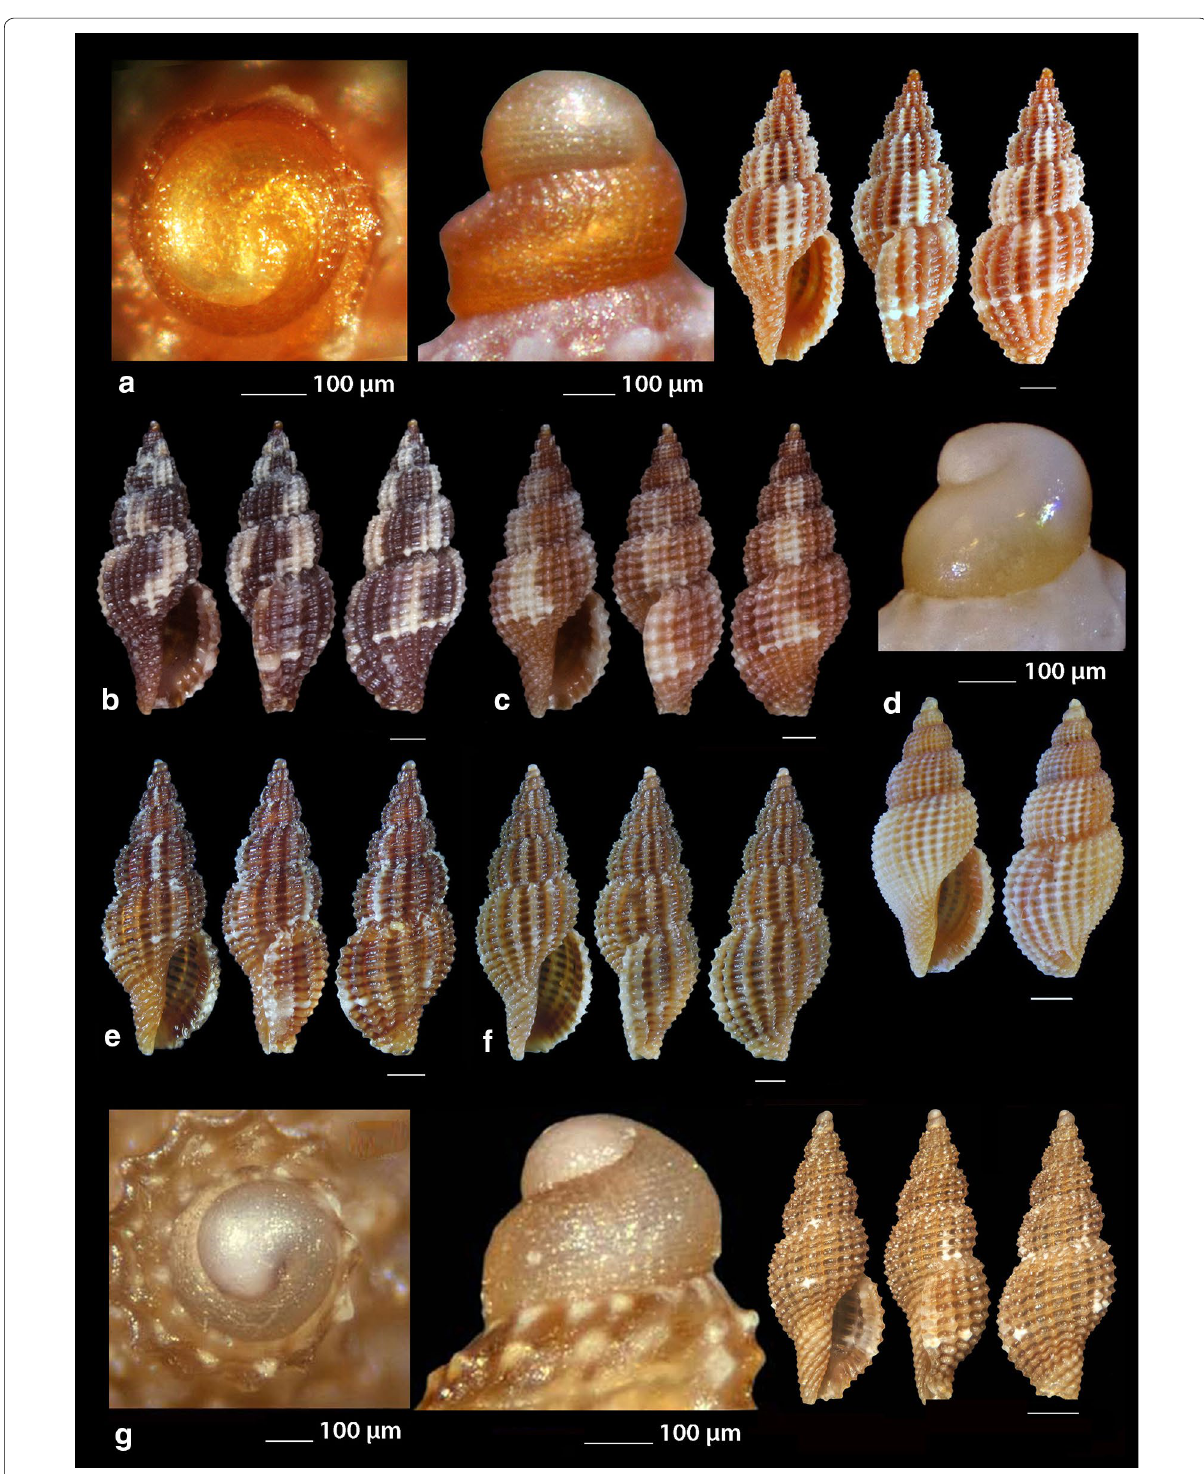
Fig. 16 a – c Raphitoma philberti , d Raphitoma pruinosa , e – g Raphitoma smriglioi. Bar